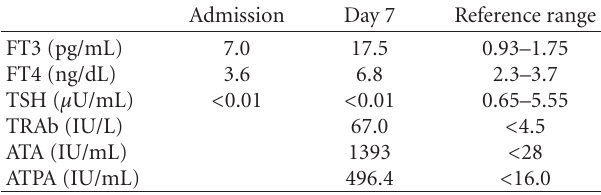
Figure 1: Chest X-ray on admission showing bilateral pulmonary infiltration and cardiac dilatation. Table 1: Blood analysis results for endocrine markers during hospitalization.